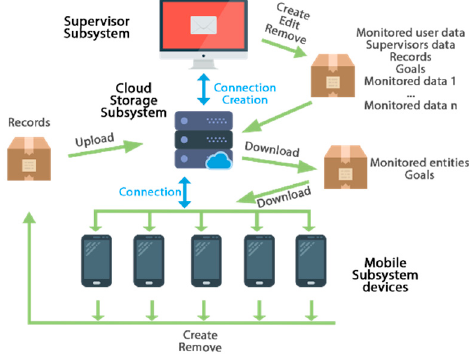
Figure 2. Communication scheme of the system.